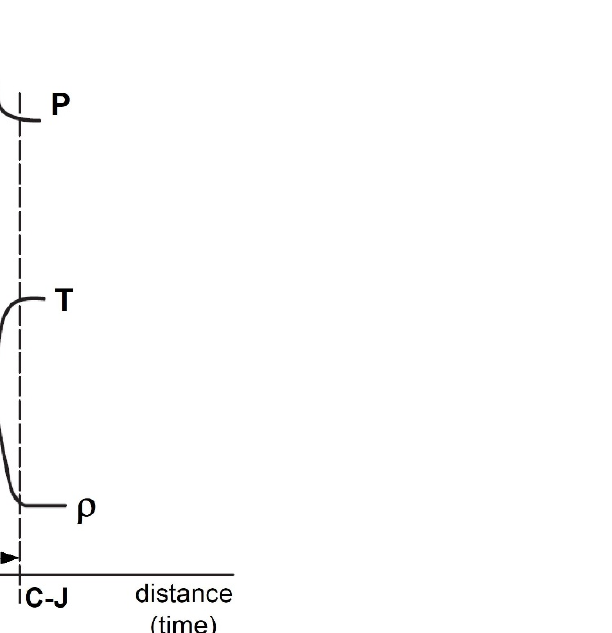
Figure 1. Change of gas thermodynamic parameters in the detonation wave area where: FU—shock wave, C-J—Chapman–Jouget plane.